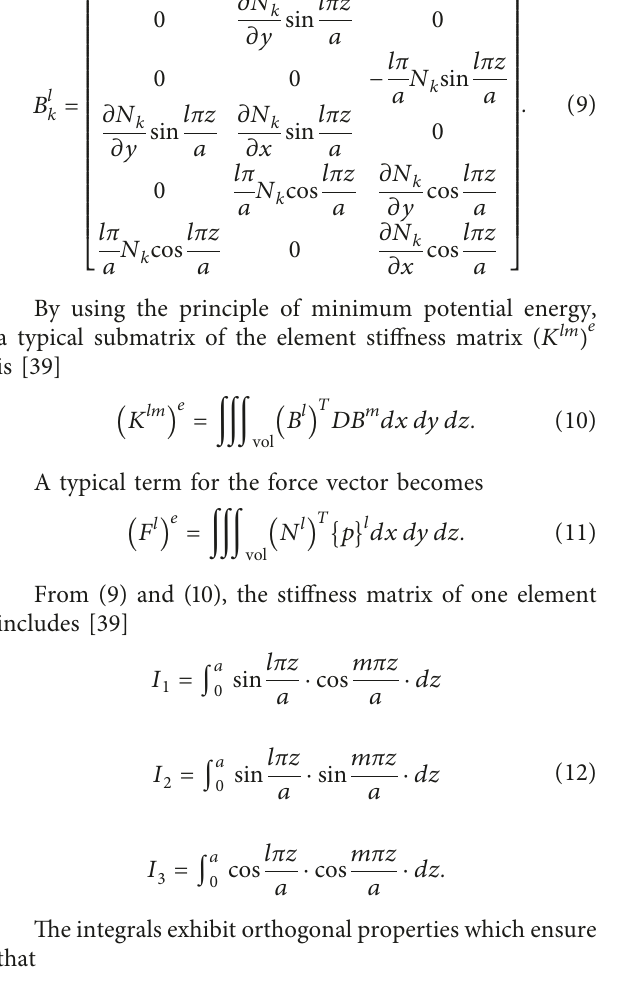
Figure 4: Schematic representation of an SAFEM